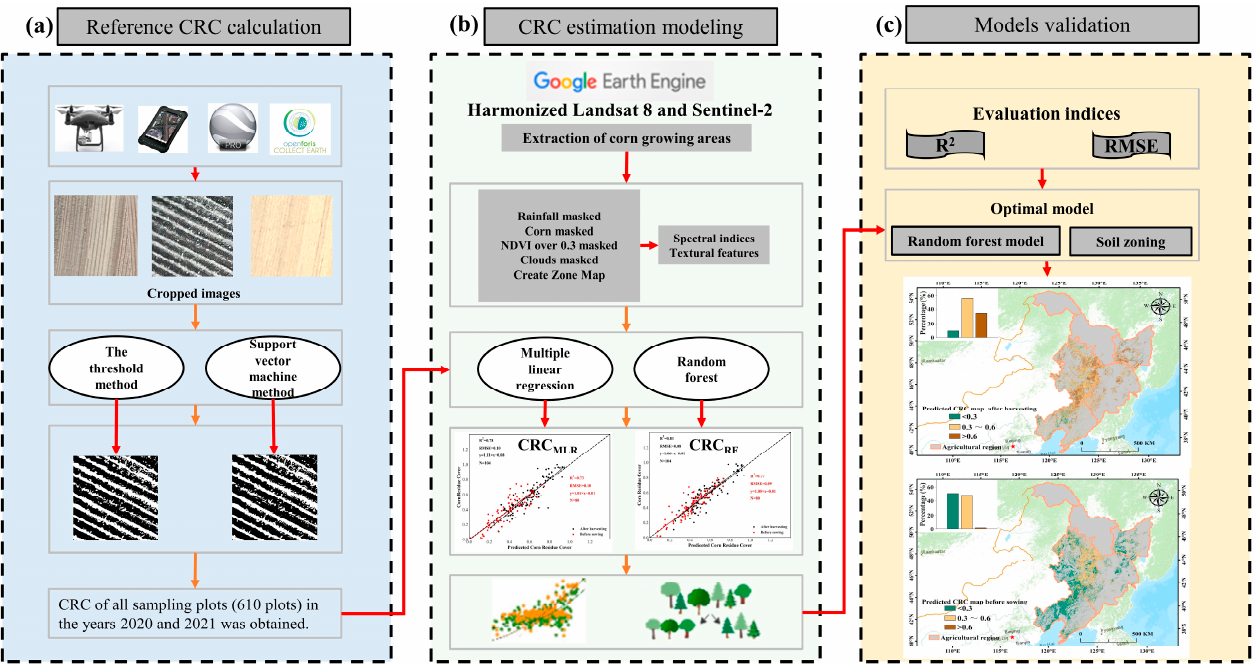
Figure 4. The fl owchart used for CRC estimation in this study. Figure 4. The flowchart used for CRC estimation in this